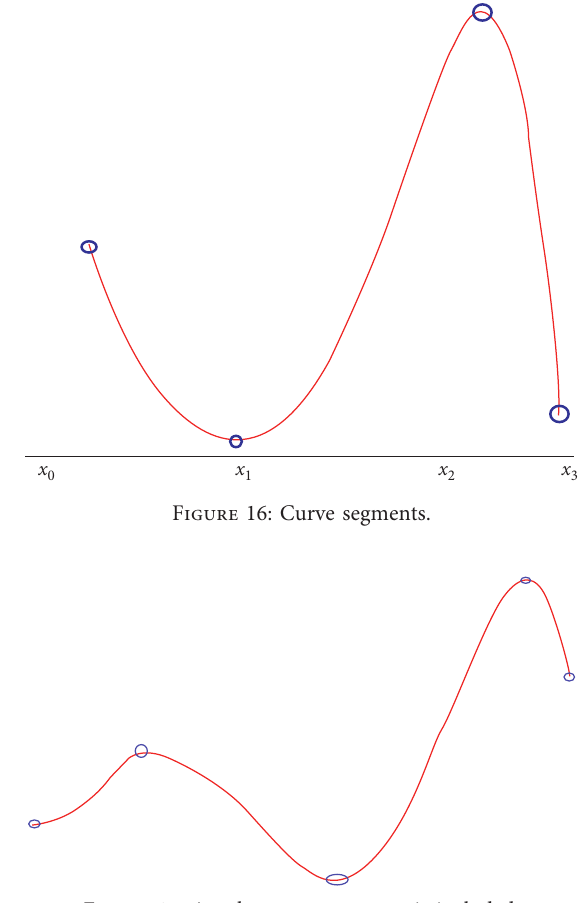
Figure 17: Another curve segment is